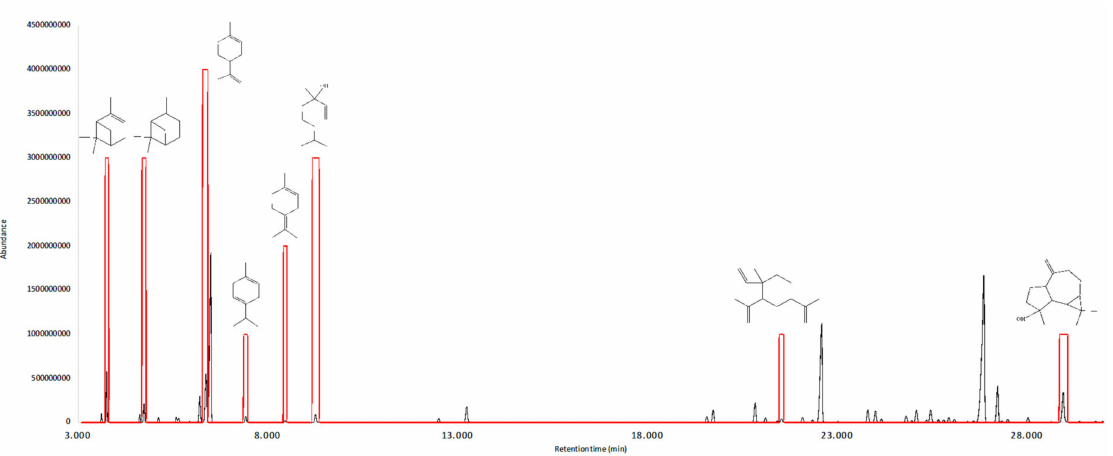
Figure 1. Gas chromatogram (black line) vs. aromagram (red line) of the essential oil from M. myrsinoides.